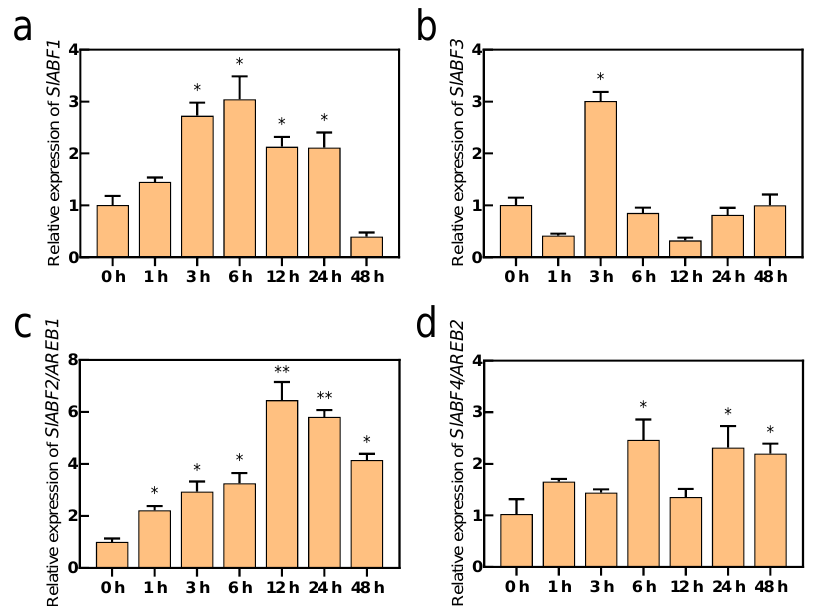
Figure 3. The expression of SlABF/AREB subfamily genes under saline-alkaline stress. The wild-type tomato seedlings with fifth true leaves were treated with 300 mM saline – alkaline mixed scheme for 0, 3, 6, 12, 24 and 48 h. The expression of (a) SlABF1 , (b) SlABF3 , (c) SlABF2/AREB1 and (d) SlABF4/AREB2 genes was measured. SlACTIN was used as an internal control. The relative expression of genes was based on saline – alkaline treatment for 0 h. Values represent averages of four independent measurements, and error bars represent standard errors. Asterisks denote a significant difference compared with the control (* p < 0.05, ** p < 0.01).